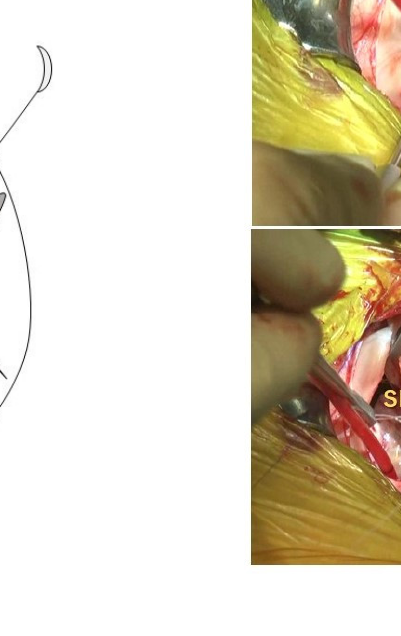
Figure 2. Modified loop technique. ( a ) Schema of the modified loop technique, in which loops of various lengths are pre-made, sterilized, and used during surgery. Further, 80% of the loops of the strut chordae (red) length were selected to repair ruptured or elongated chordae tendineae (yellow). ( b ) Using a ruler, the length of the strut chordae (top) was measured. Then, three loops (white arrow), each 80% of the length of the strut chordae, were fixed to the cranial and caudal papillary muscles with a double-armed suture. Of the three loops, two are fixed to the septal leaflet and one to the mural leaflet with simple interrupted sutures (bottom). The loops of the mural leaflet and the center of the septal leaflet are ligated at two points at the valve leaflet. Ao: Aorta; SL: Septal leaflet; ML: mural leaflet; LA: left atrium.